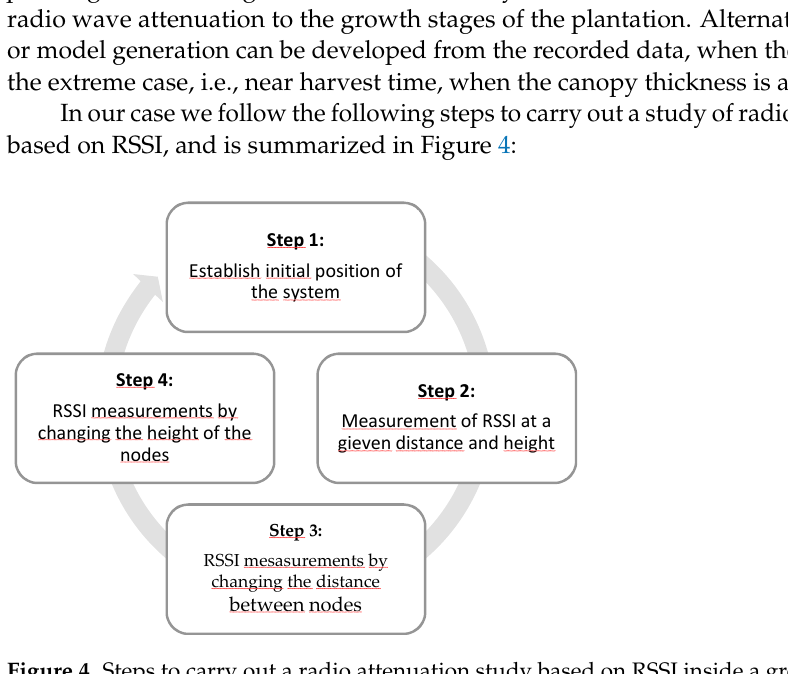
Figure 4. Steps to carry out a radio attenuation study based on RSSI inside a greenhouse. Step 1: Initial position of the system. The position of the receiving station is fixed, as it is powered by a 220 V electrical current from a socket in the greenhouse. In any study with the system, the receiving station depicted as Rx is the reference node where the RSSI is to be measured. For instance, in Figure 5A the positions of the receiving nodes are shown in red (A1, A2, A3, A4) at one end of the greenhouse during the measurement of RSSI.